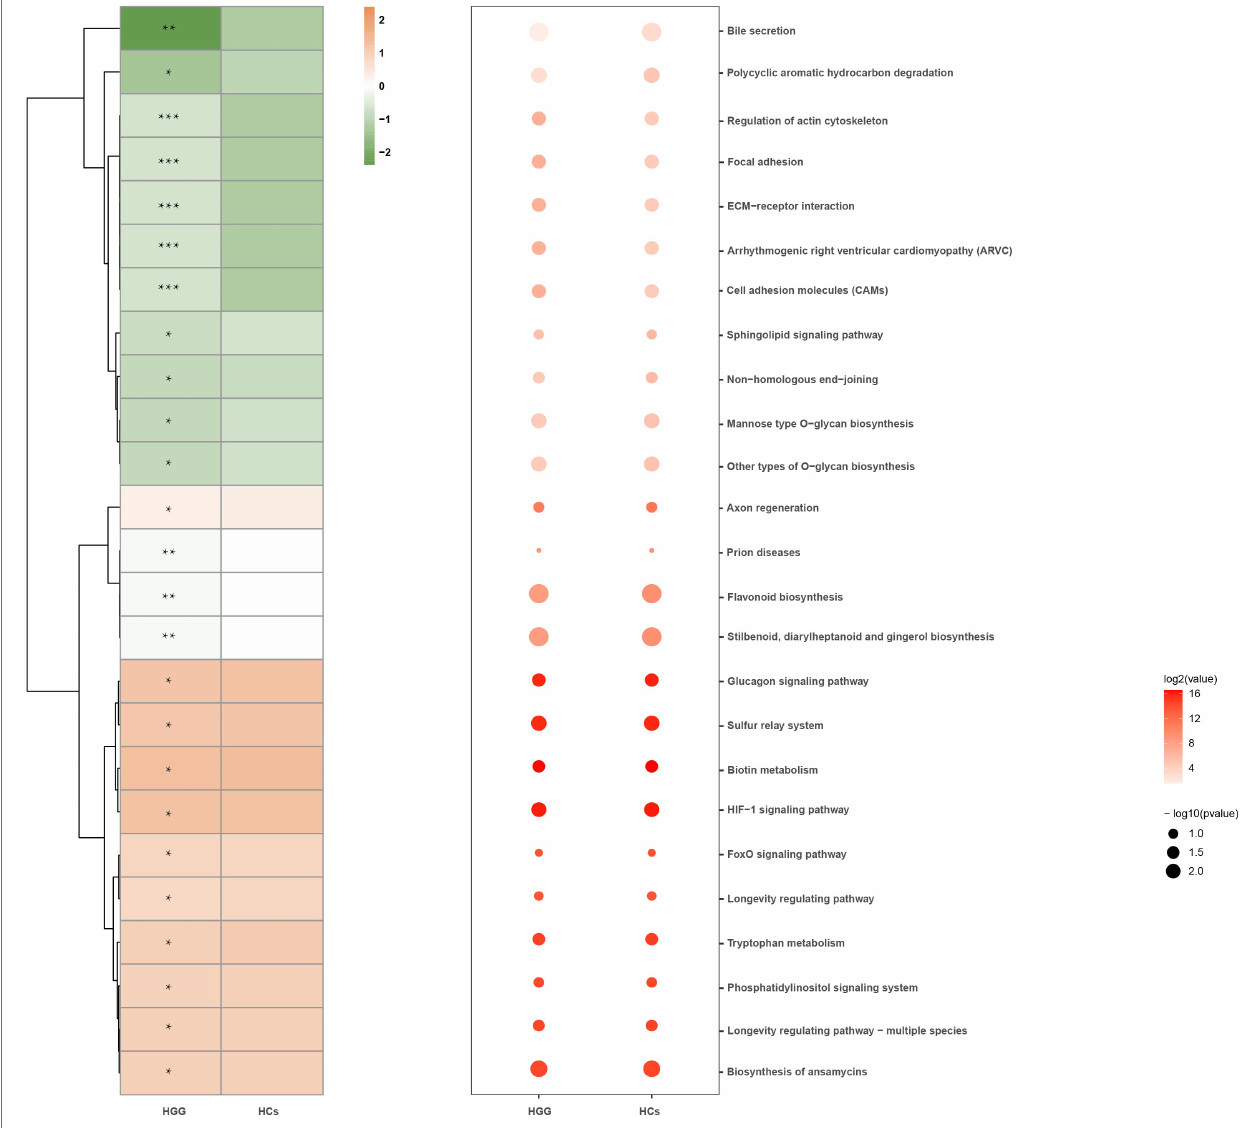
FIGURE 5 | Microbial functions altered in the HCs and HGG. Heat map showing the medial abundance of all significant modules as determined by PICRUSt analysis at HCs and HGG. * p < 0.05, ** p < 0.01, *** p < 0.001. PICRUSt, Phylogenetic Investigation of Communities by Reconstruction of Unobserved States; HCs, healthy controls; HGG, high-grade